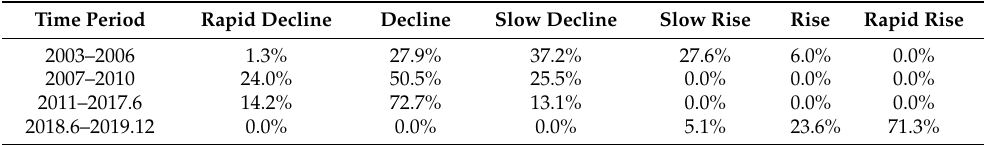
Figure 9. Spatial distribution of groundwater storage anomaly change rate in the SRB in four phases: Table 3. Area percentage of six types of groundwater storage changes in the SRB from 2003 to 2019.